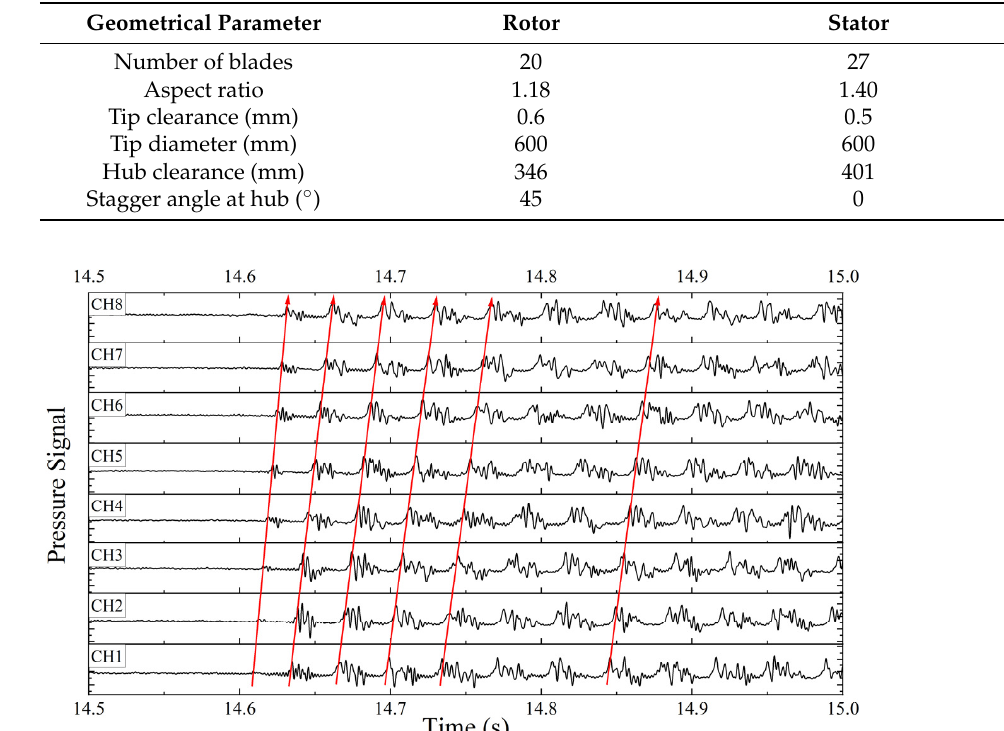
Figure 2. Time-resolved static pressure disturbance of Plane B at 100% design working speed. Table 1. The aerodynamic design parameters of TA36 [41].